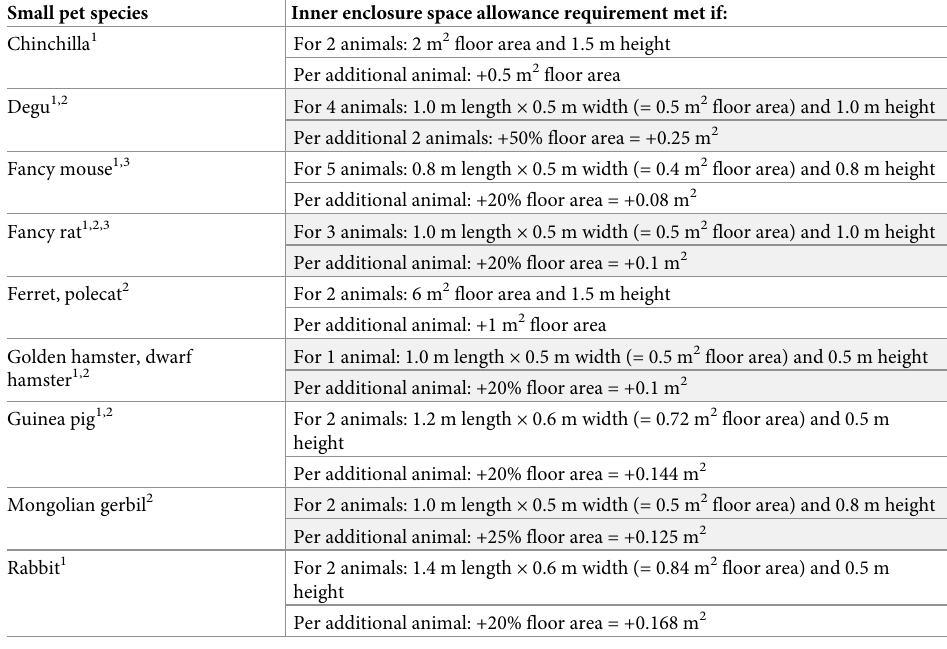
Table 2. Cage dimension (inner enclosure space allowance) requirements for small mammal pets and ferrets. Small pet